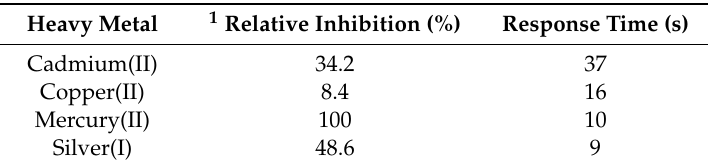
Table 3. Inhibitory e ff ect of selected heavy metals to